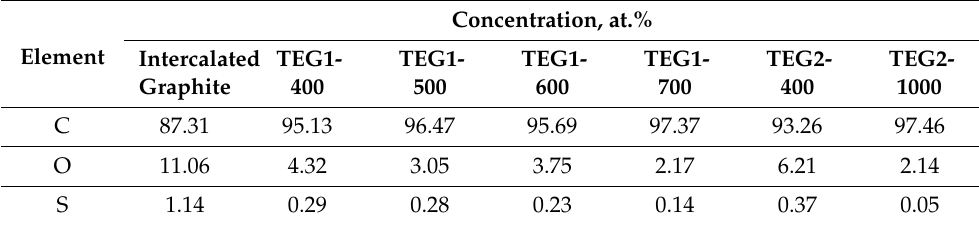
Table 2. Concentration of the main elements in the EG samples (EDX). Element